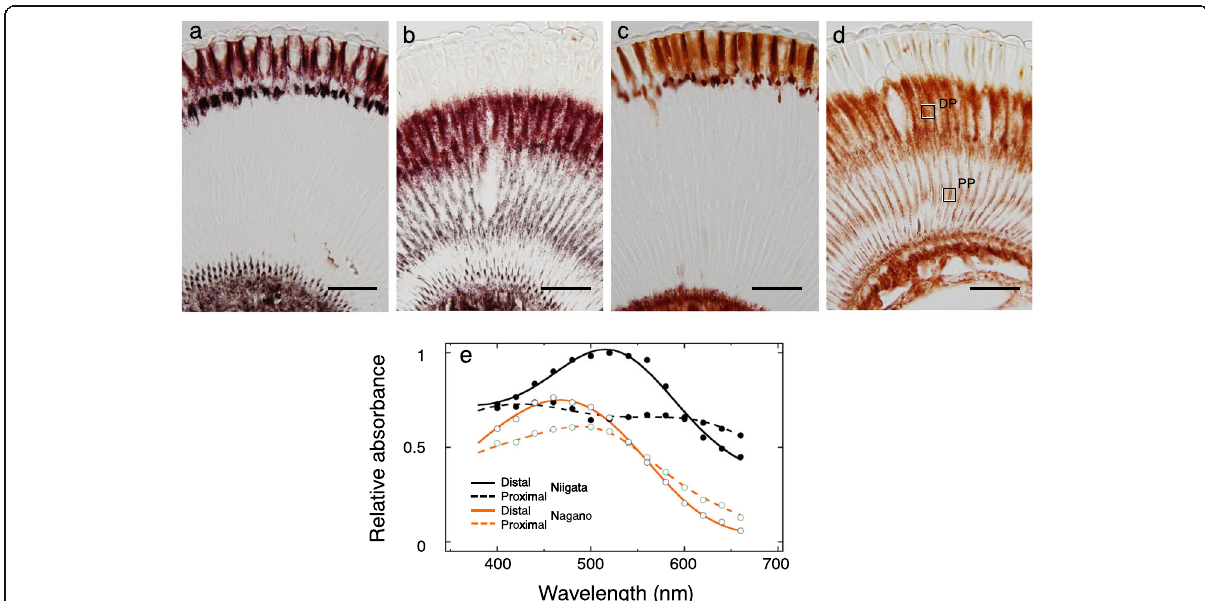
Fig. 2 Light micrographs of longitudinal sections of the eye. a Dark-adapted male from the Niigata strain. b Light-adapted, Niigata. c Dark-adapted, Nagano. d Light-adapted, Nagano. e Absorption spectra of distal pigmented (DP) and proximal pigmented (PP) regions, which are exemplarily indicated by squares in d . Circles indicate IMSP data and the lines indicate heuristically modeled fits (Table 1). Average of the measurements from 3 points in each strain.